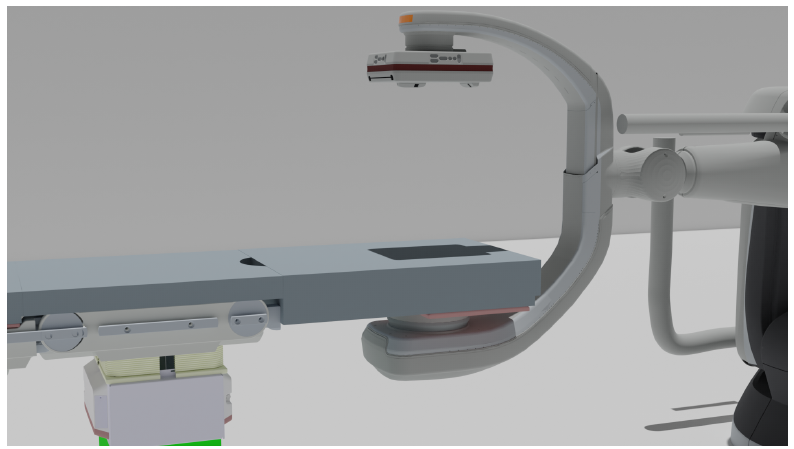
Figure 8. OR table collision with an angiography system.